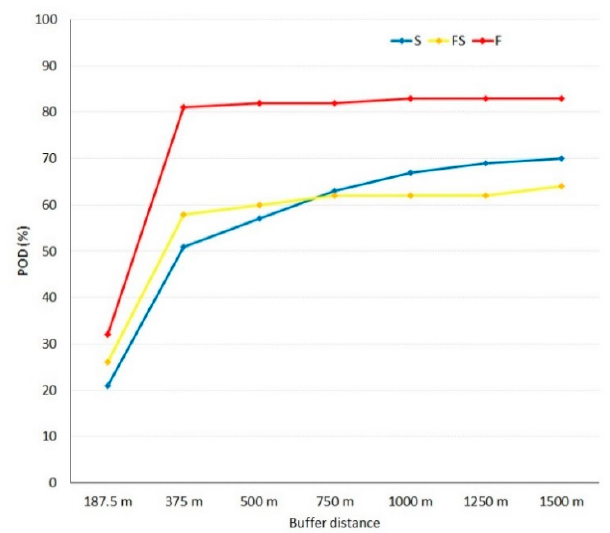
Figure 13. POD of peatland combustion (S, FS, and F) detected by VNP14IMG from day-time and night-time data in buffered zones of 187.5 m to 1500 m.